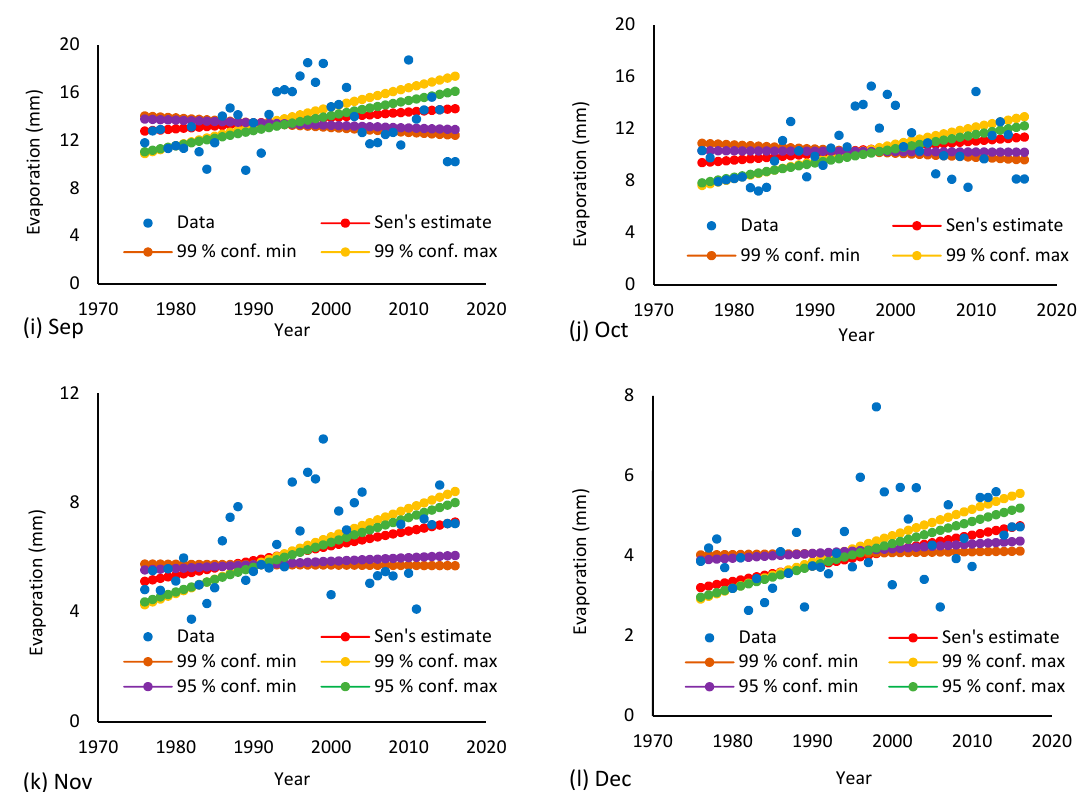
Figure 4. Trends of evaporation data in the month of: ( a ) January; ( b ) February; ( c ) March; ( d ) April; ( e ) May; ( f ) June; ( g ) July; ( h ) August; ( i ) September; ( j ) October; ( k ) November; and ( l ) December. Table 3. Trend analysis results for evaporation ( Z values).